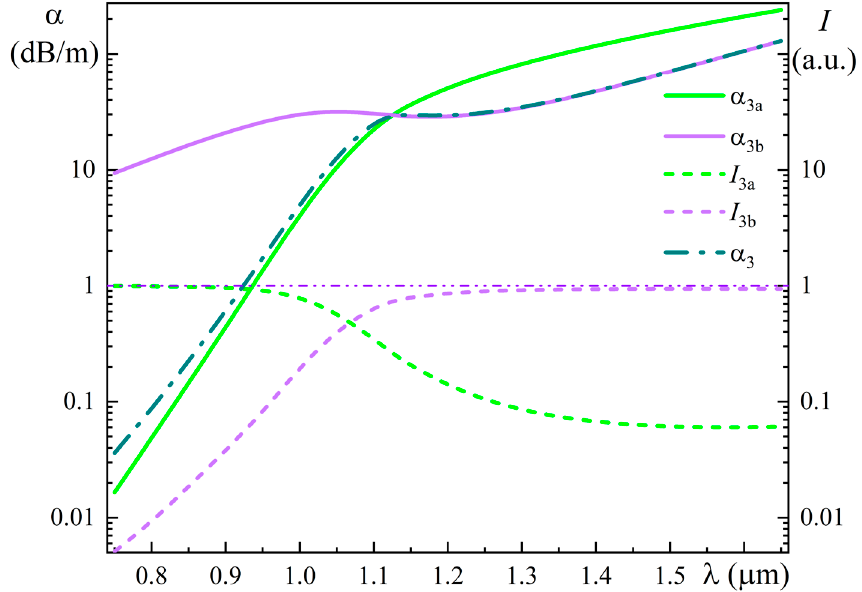
Figure 5. Spectral dependences of the leakage losses ( α 3a and α 3b ) and intensities ( I 3a and I 3b ) of Modes 3a and 3b in the straight MOF-18, and the resulting leakage loss for Mode 3 ( α 3 ). Using the algorithm described above, we calculated the spectral dependence of the leakage loss α 3 for Mode 3 for the length L = 2 m, as presented in Figure 5. Note that the